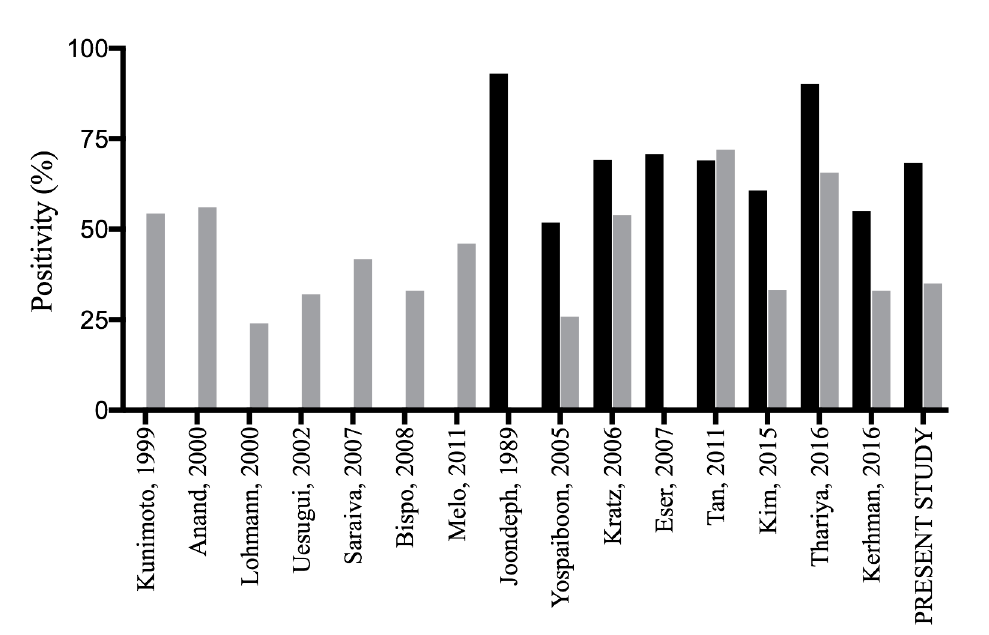
Figure 1 - Positivity (%) of vitreous sample cultures of patients with endophthalmitis using the conventional method (gray) and pediatric blood culture bottles (black) in the medical literature and including the present